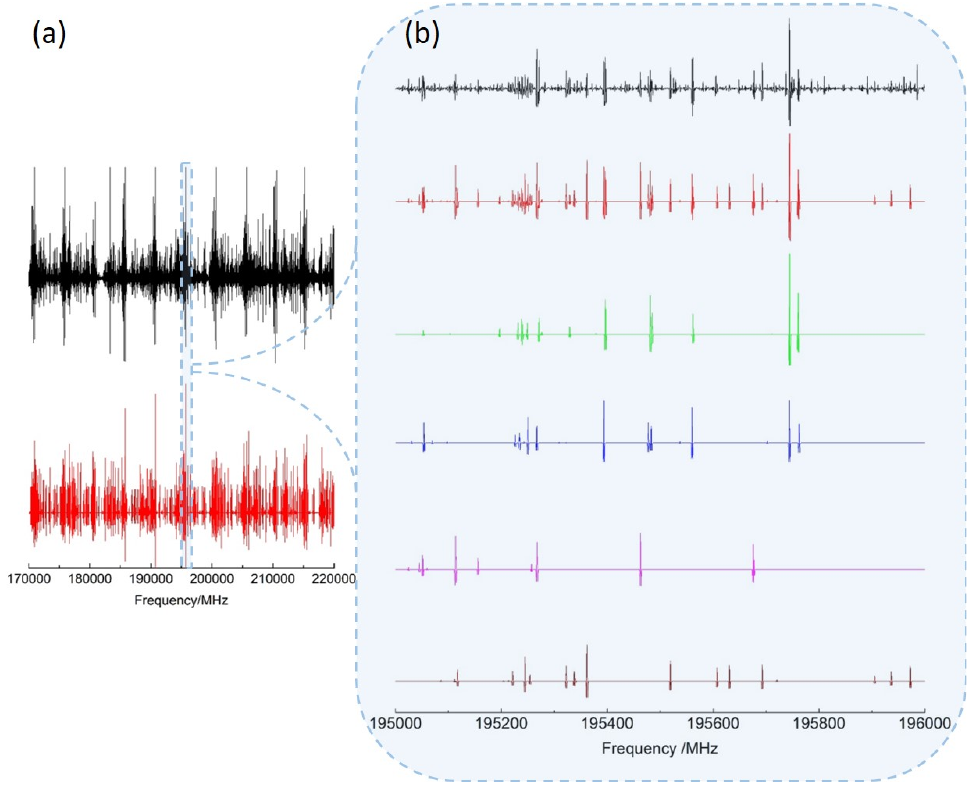
Figure 3. ( a ) Experimental (black) and calculated (red) rotational spectra of 3-MF in the 170–220 GHz frequency range. ( b ) Zoom on a 1 GHz range highlighting the different species contributing to the calculated spectrum: v t = 0 A (green) and E (blue) species; v t = 1 A (magenta) and E (brown)